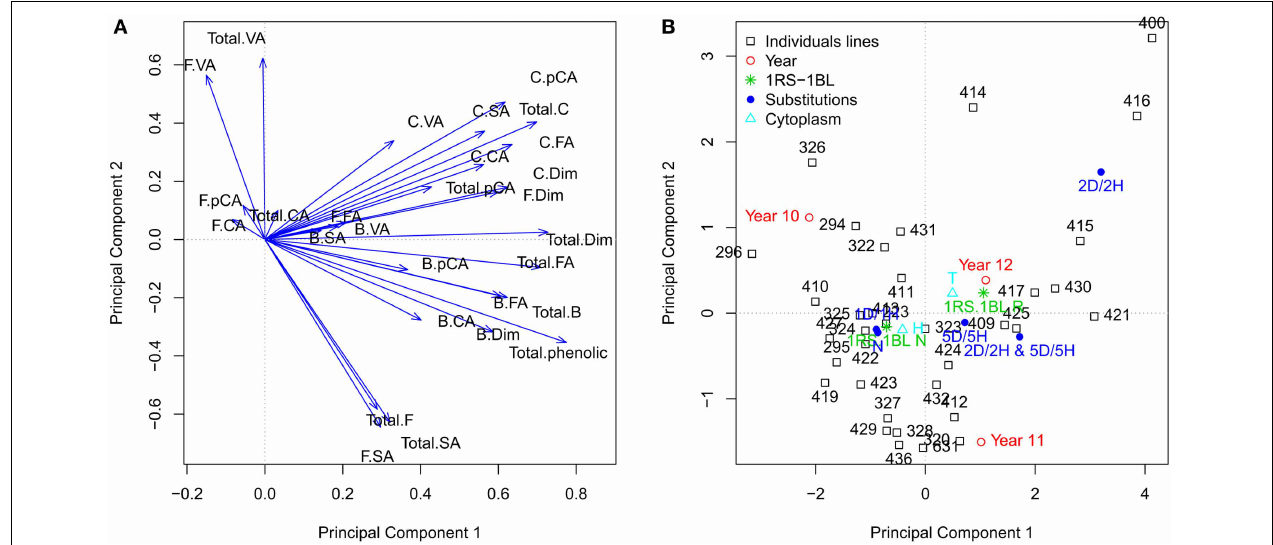
FIGURE 2 | Principal components analysis. (A) The quantitative variables are represented. (B) The individuals lines and the centroids of levels factors “Year,” “Sustitutions,” “1RS/RL,” and “Cytoplasm” are represented.x “B.FA,” “F.FA,” “C.FA,” “Total.FA” are bound, free, conjugated and total ferulic acid; “B.VA,” “F.VA,” “C.VA,” “Total.VA” are bound, free, conjugated and total vanillic acid; “B.pCA,” “F.pCA,”